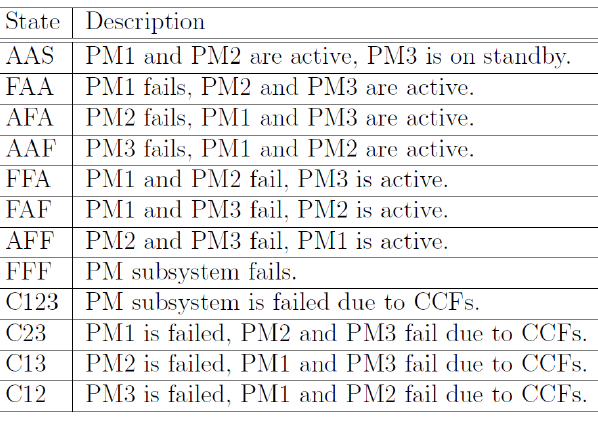
Fig. 4. CTMC for PM subsystem in presence of CCFs Table 1. The states of PM